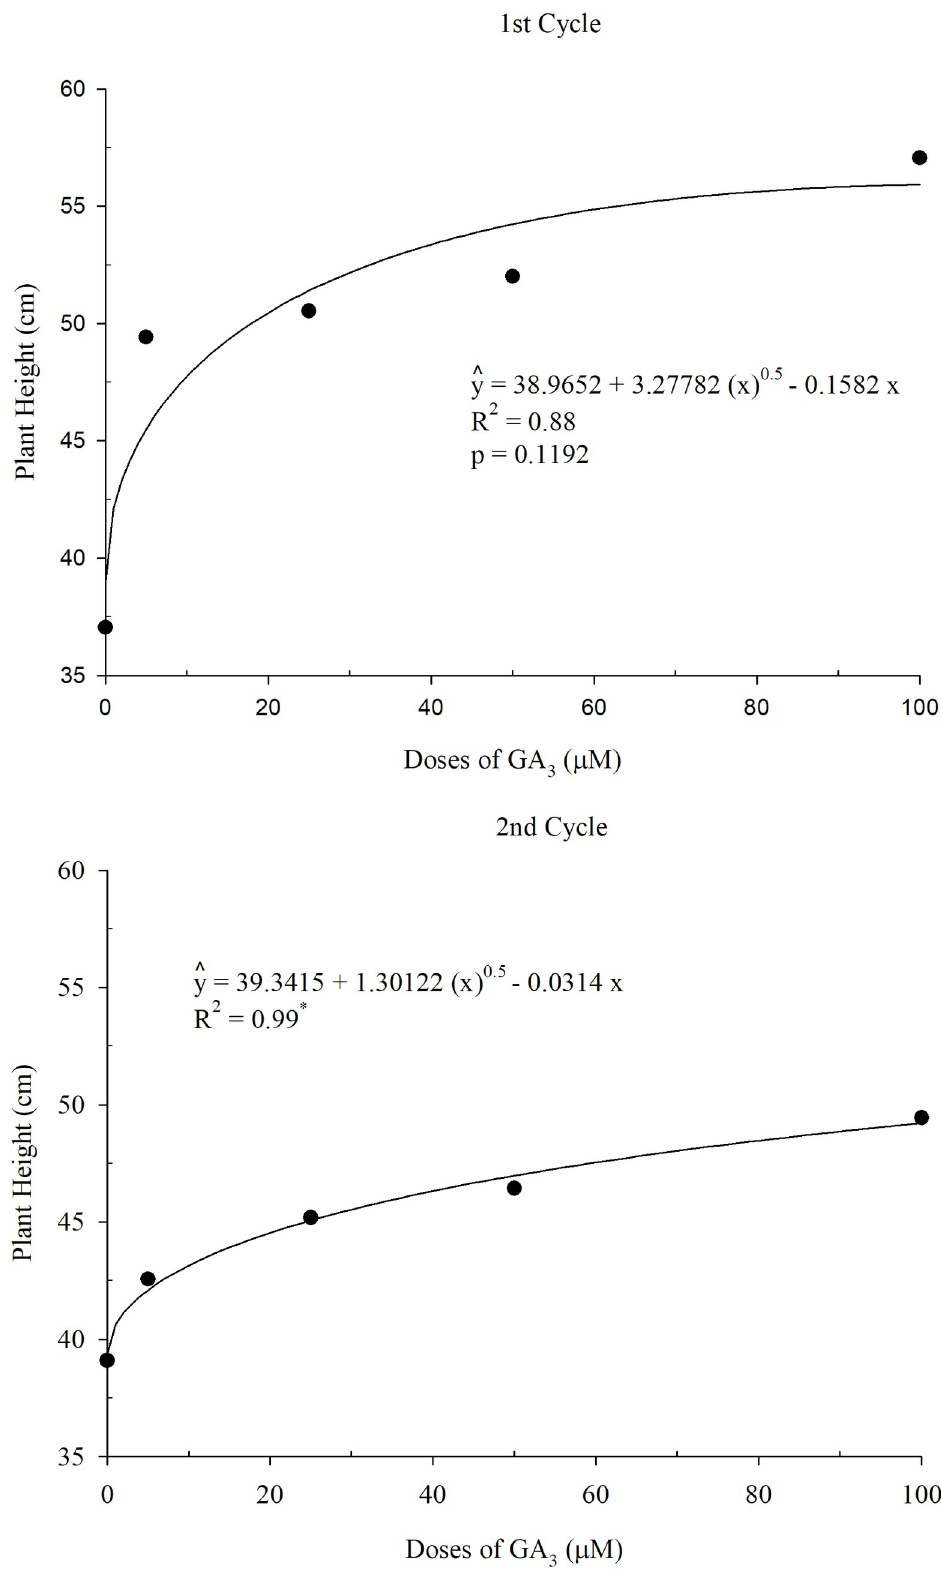
Fig 3. Plant height depending on the doses of GA 3 (1st and 2nd cycles). https://doi.org/10.1371/journal.pone.0206378.g003 PLOS ONE | https://doi.org/10.1371/journal.pone.0206378 October 26,